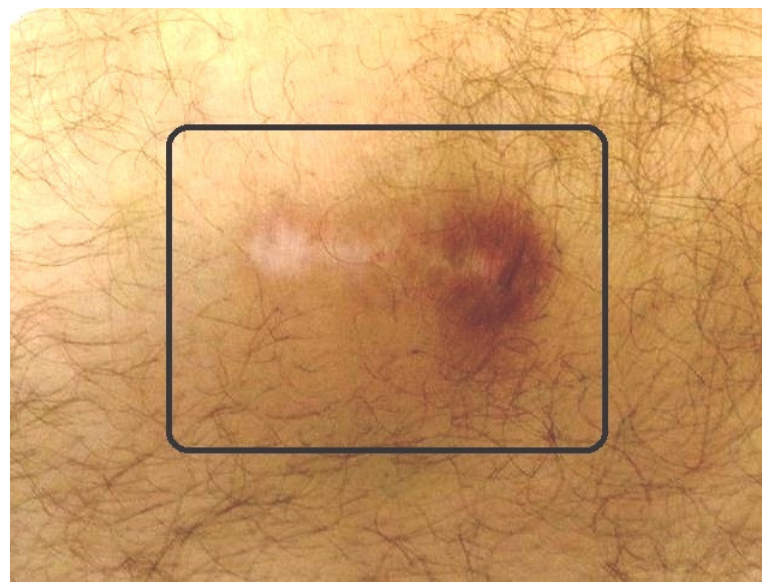
Figure 6. Small radioactive burn of the adjacent skin (square) after knee radiosynovectomy (RS). 7. Is Radiosynovectomy Safe?